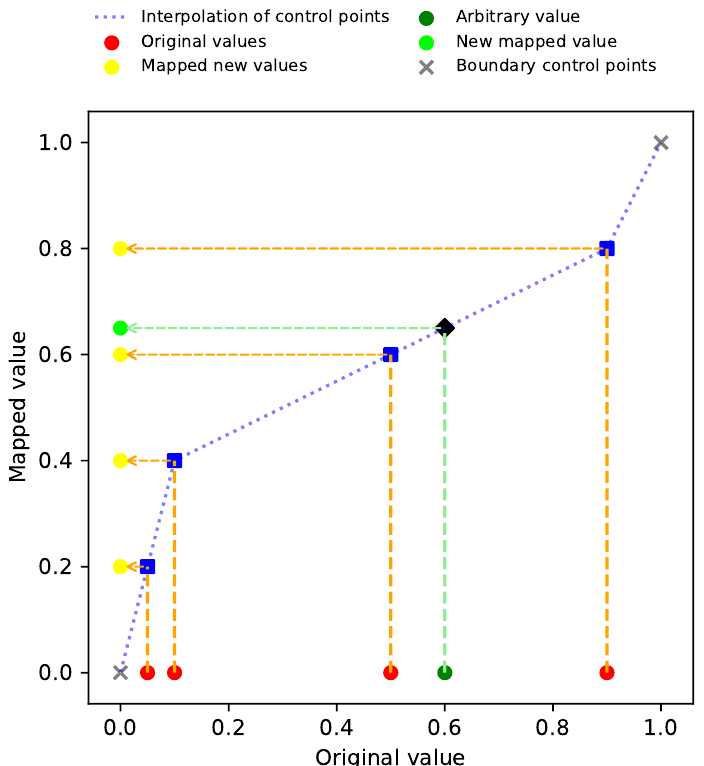
Figure 2. Mapping of parameters with control